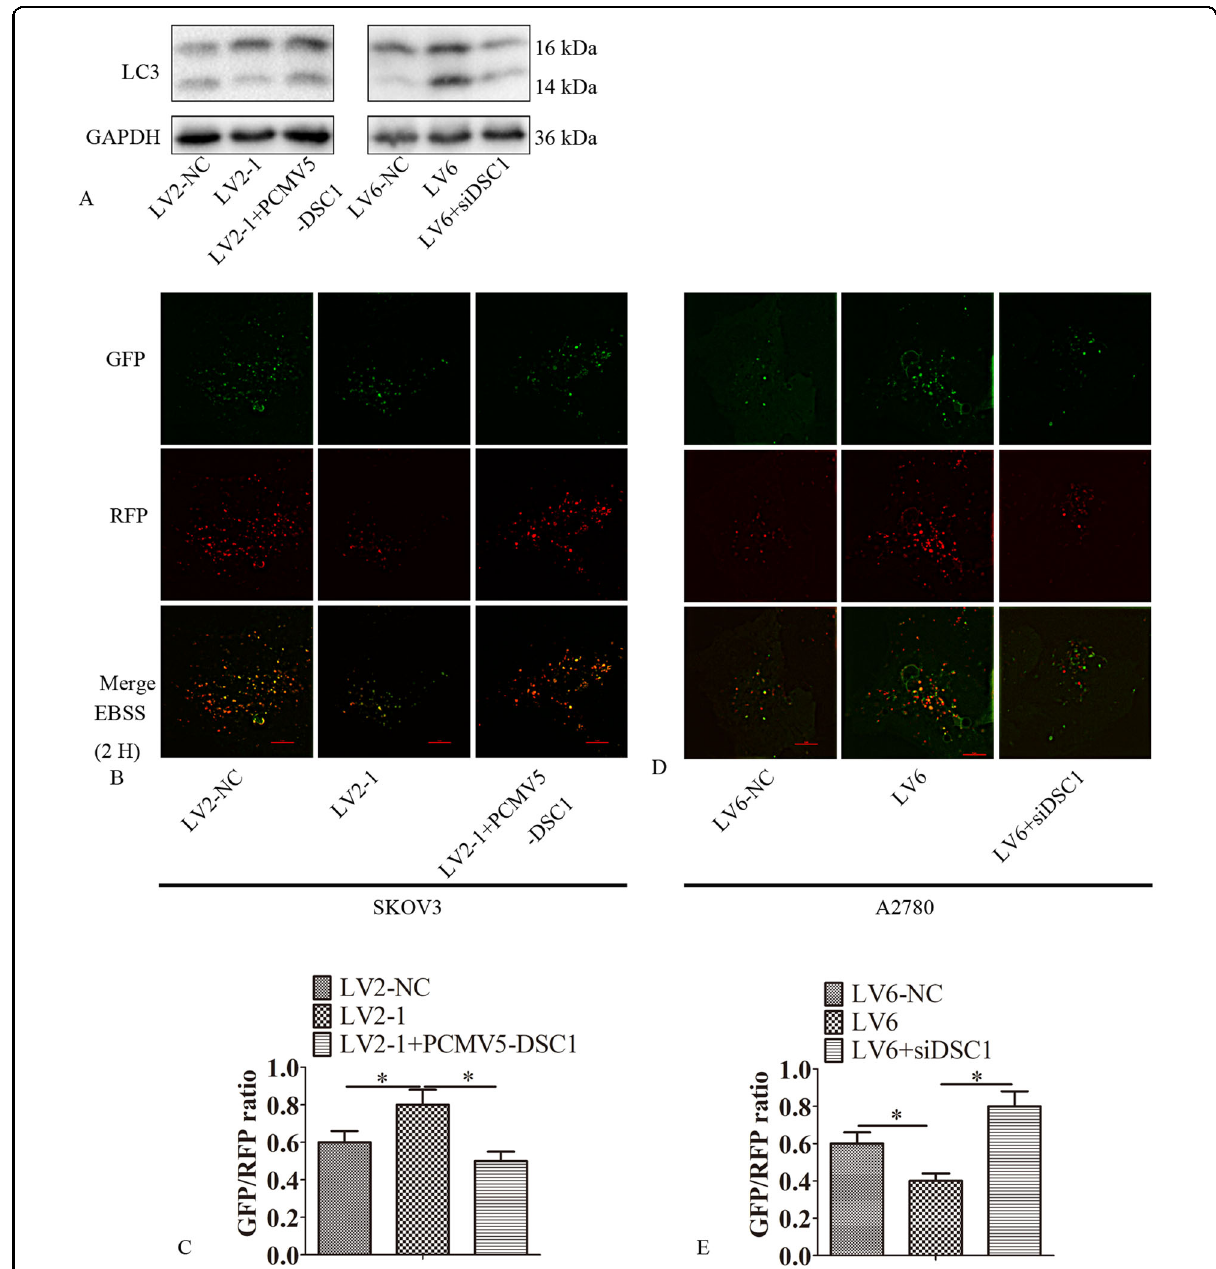
Fig. 8 CircRAB11FIP1 enhanced the DSC1-dependent autophagy. A LV2-1, LV2-NC, or LV2-1 + PCMV5-DSC1 was used to transfect SKOV3 cells. LV6, LV6-NC, or LV6 + DSC1 siRNA was utilized to transfect A2780 cells. Later, LC3 expression was detected through western blot analysis. B , C LV2-1, LV2-NC, or LV2-1 + PCMV5-DSC1 was transfected into SKOV3 cells. Later, confocal microscopy was performed to analyze the distribution of mRFP- GFP-LC3 within SKOV3 cells. D , E LV6, LV6-NC, or LV6 + DSC1 siRNA was transfected into A2780 cells. Thereafter, confocal microscopy was